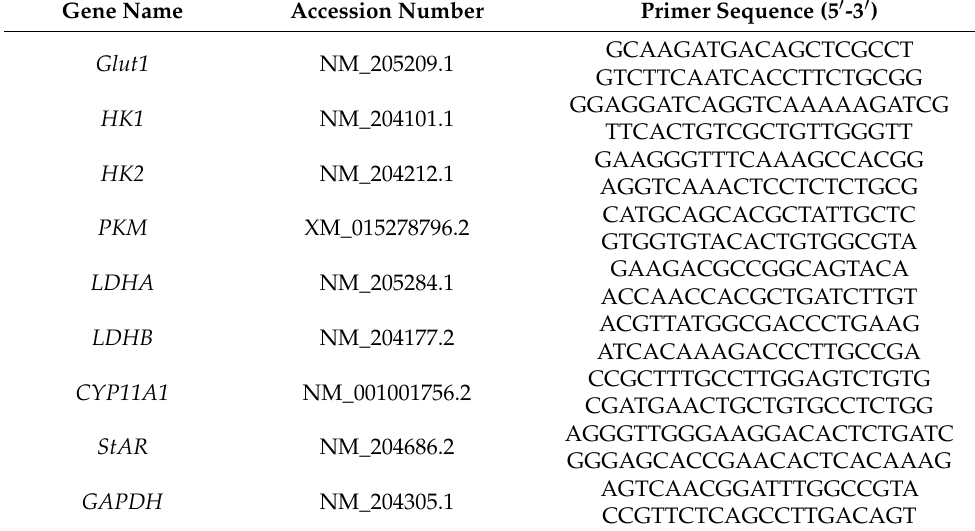
Table 1. Primers for PCR